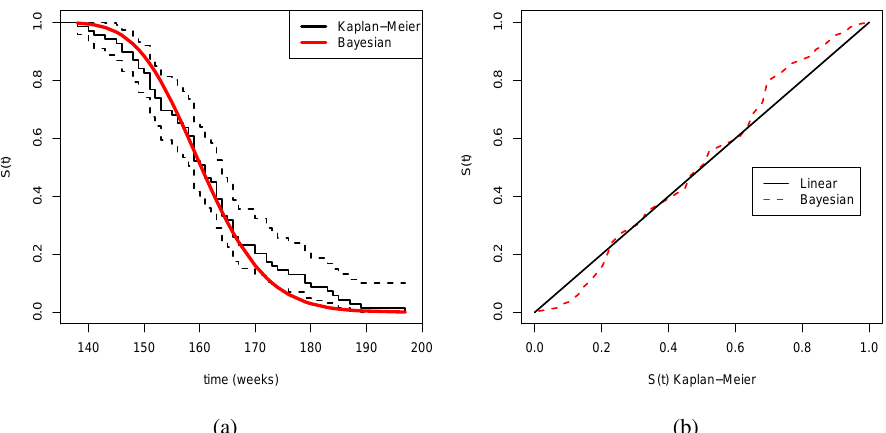
Fig. 5. (a) Comparison between survival functions generated by the Bayesian method and Kaplan-Meier estimator described by plotting S ( t ) versus time. (b) Comparison between survival functions generated by the Bayesian method described by plotting S ( t ) versus Kaplan-Meier